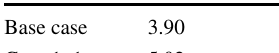
Table 18 SRV from well-lateral length